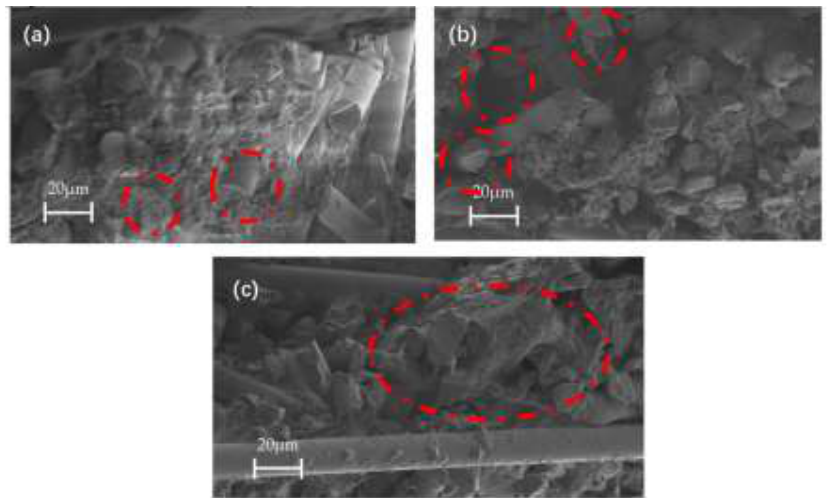
Figure 9. SEM cross-sectional image of impact fracture pattern of Glass Fibre Fabric Reinforced PPS Composite ( a ) PPS (particle) and glass fibre tow; ( b ) PPS (film) and glass fibre tow; ( c ) combination of film and particle.